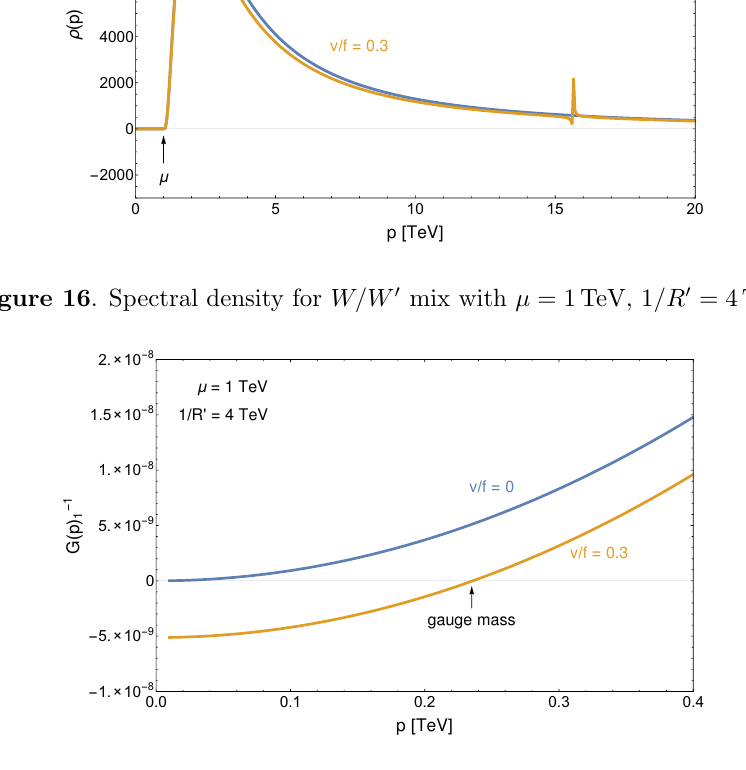
Figure 17 . Inverse Green’s function for W=W 0 mix with (cid:22) = 1 TeV ; 1 =R 0 = 4